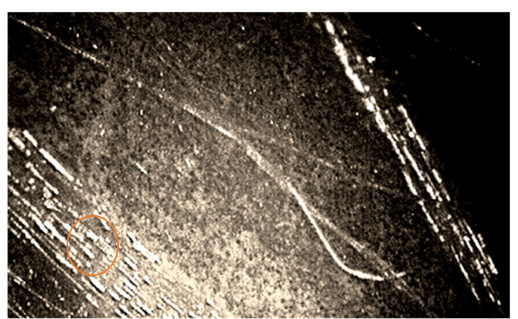
Figure 4. Image of the mycelium of fungi of the genus Aspergillus at the border “fiber-binder (hardener)-fungal mycelium-fiber” and cells of bacteria of the genus Bacillus , polarizing microscopy, × 1000 magnification.